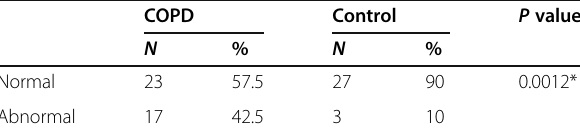
Table 3 Comparison between patient and control groups as